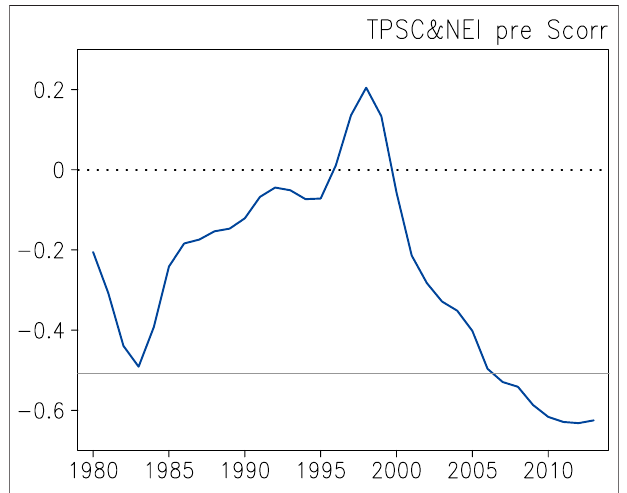
FIGURE 4 | Sliding correlation coef fi cient between the interannual western Tibetan Plateau summer snow cover index (TPSC) and interannual northeast Indian summer precipitation index (NEI pre) with a 15-years moving window for the period 1973 — 2020. The gray line denotes the 15-years sliding correlation coef fi cient signi fi cant at the 95% con fi dence level.